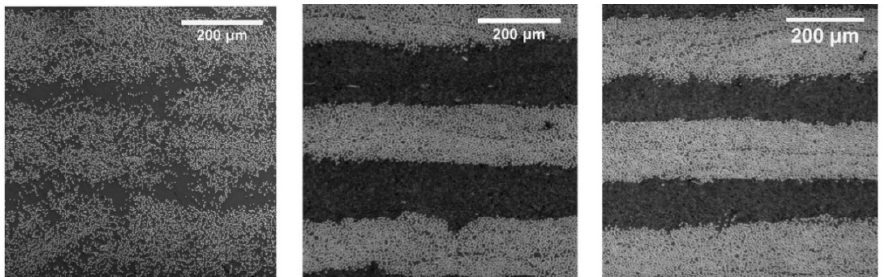
Figure 9. Optical microscopy records of prepreg laminates, from left to right: unfilled, 15 vol% of small particles, 15 vol% of large particles.